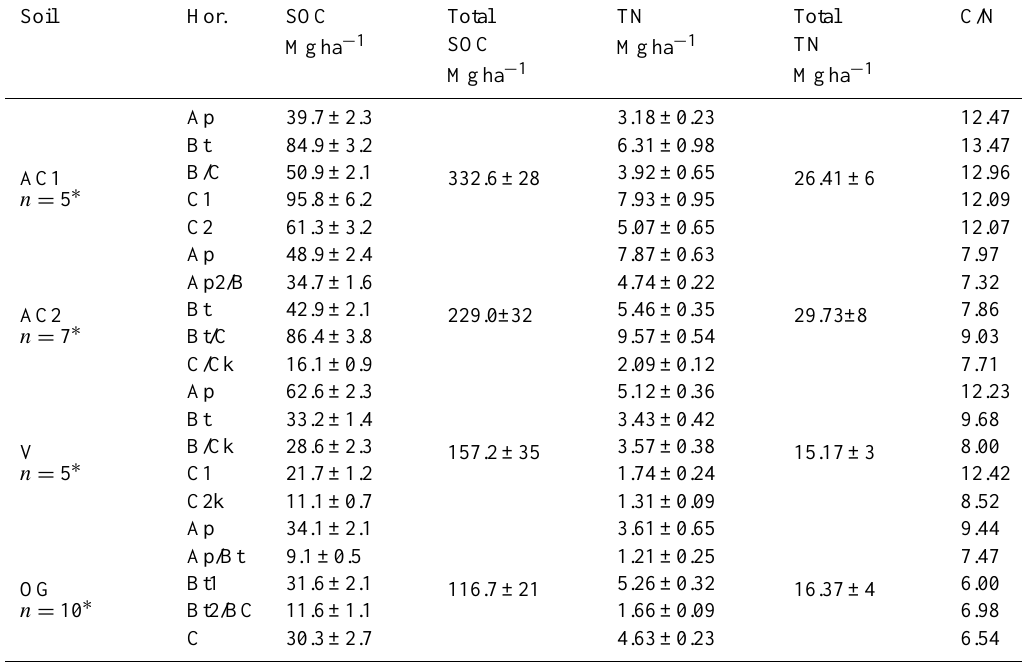
Table 3. Soil organic carbon, total nitrogen and C:N ratio stock in Calcic/Chromic Luvisol. Data are means ±SD ( n = 5, 7, 5, 10). Soil